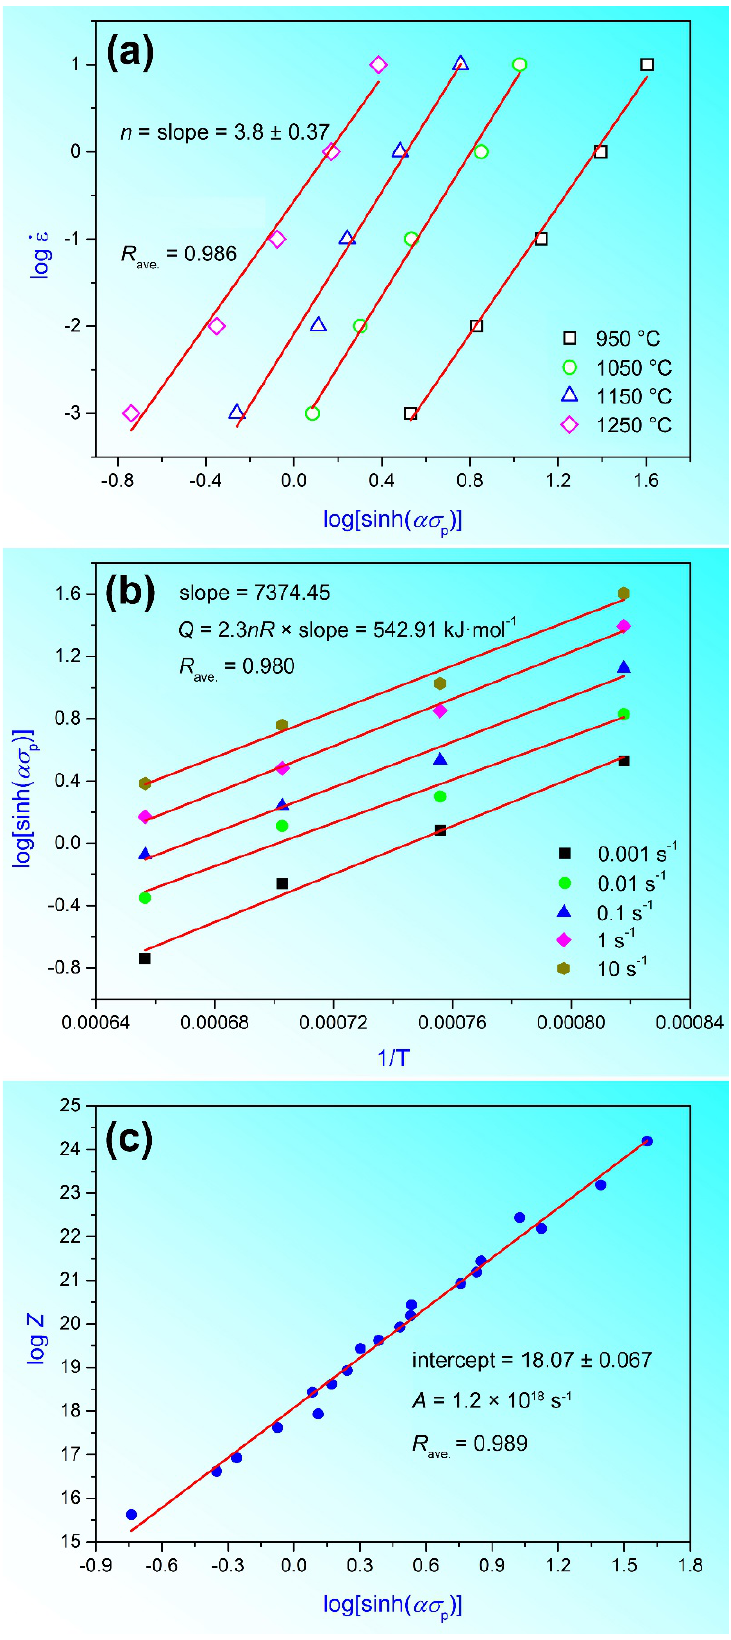
. . and log[sinh( ασ )], where is in s −1 ( a ), the plot between Figure 5. The plot between Figure 5. The plot between log ε and log[sinh( ασ )], where ε is in s − 1 ( a ), the plot between log[sinh( ασ )] log[sinh( ασ )] and 1/ T , where T is in K ( b ), the plot between log Z and log[sinh( ασ )] ( c ). and 1/ T , where T is in K ( b ), the plot between log Z and log[sinh( ασ )] ( c log 𝜀𝜀̇ 𝜀𝜀̇ By inserting the values of α and n into Equation (5), the relationship plots between and 1/ T at different strain rates can be drawn, as presented in Figure 5b. The value of activation energy Q can be calculated by averaging the slope value of the log[sinh( 𝛼𝛼𝛼𝛼 )] fitted straight line at each strain rate. The Q of the coarse-grained S31254 SASS is